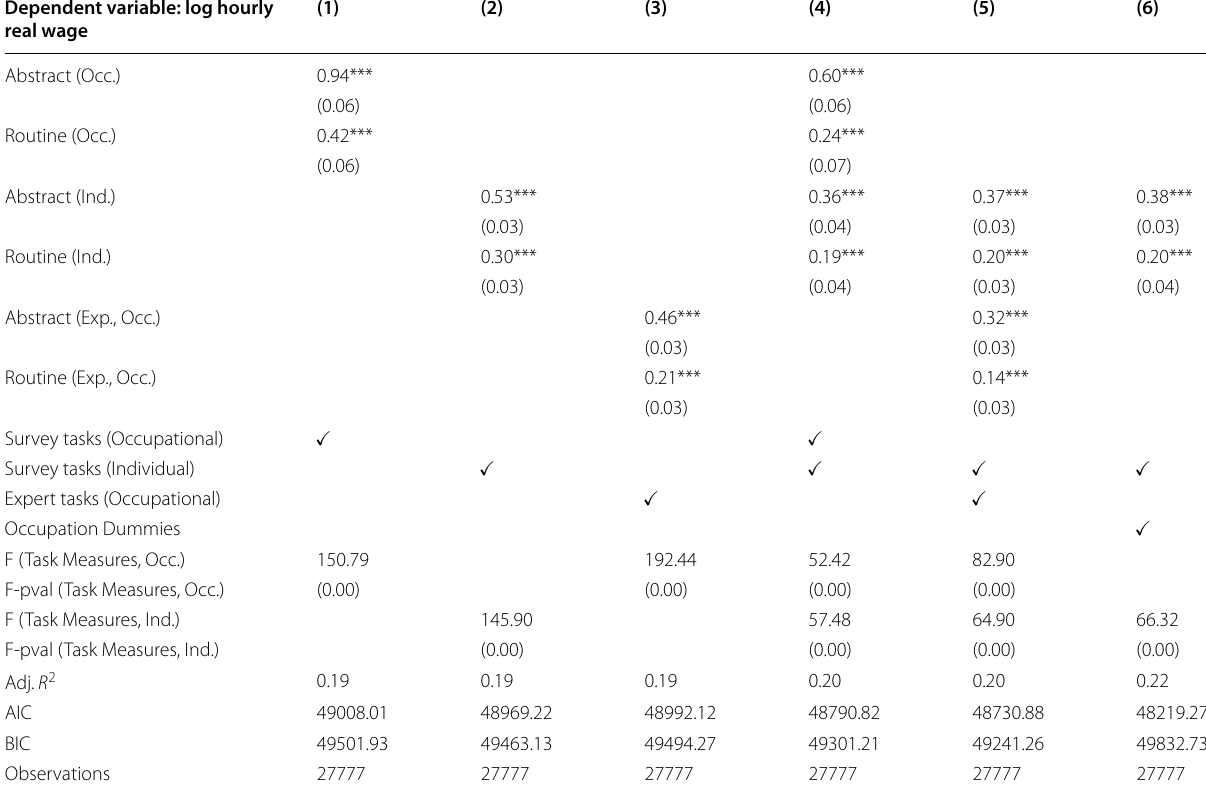
Robust standard errors in